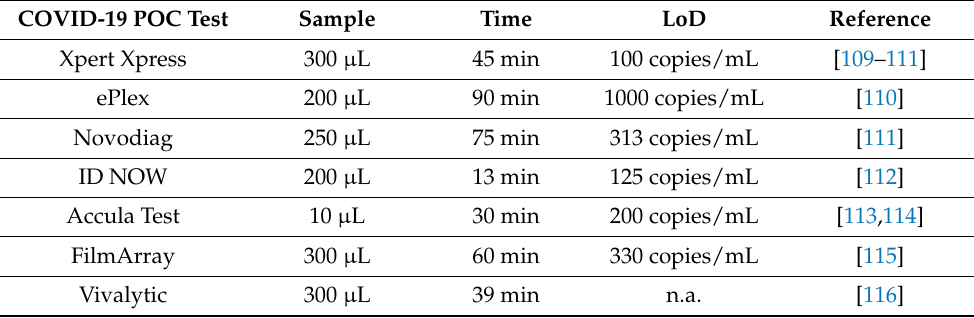
Table 5. List of patented and authorized POC for SARS-CoV-2